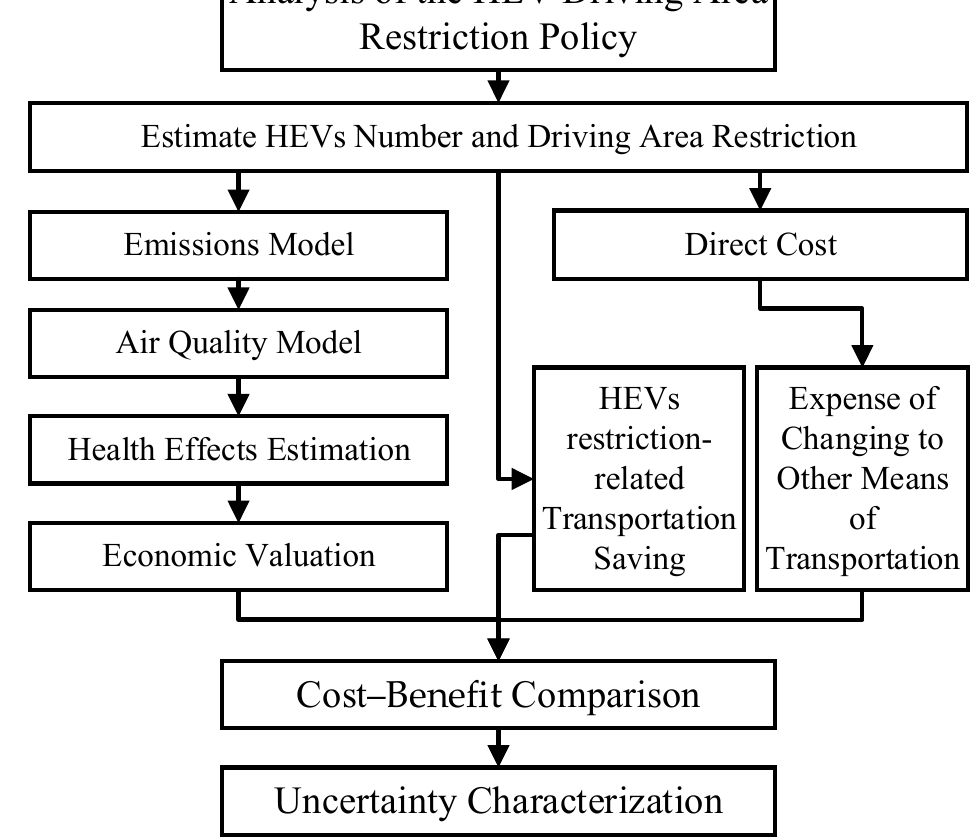
Figure 1. Analytical sequence of the HEV driving area restriction policy.